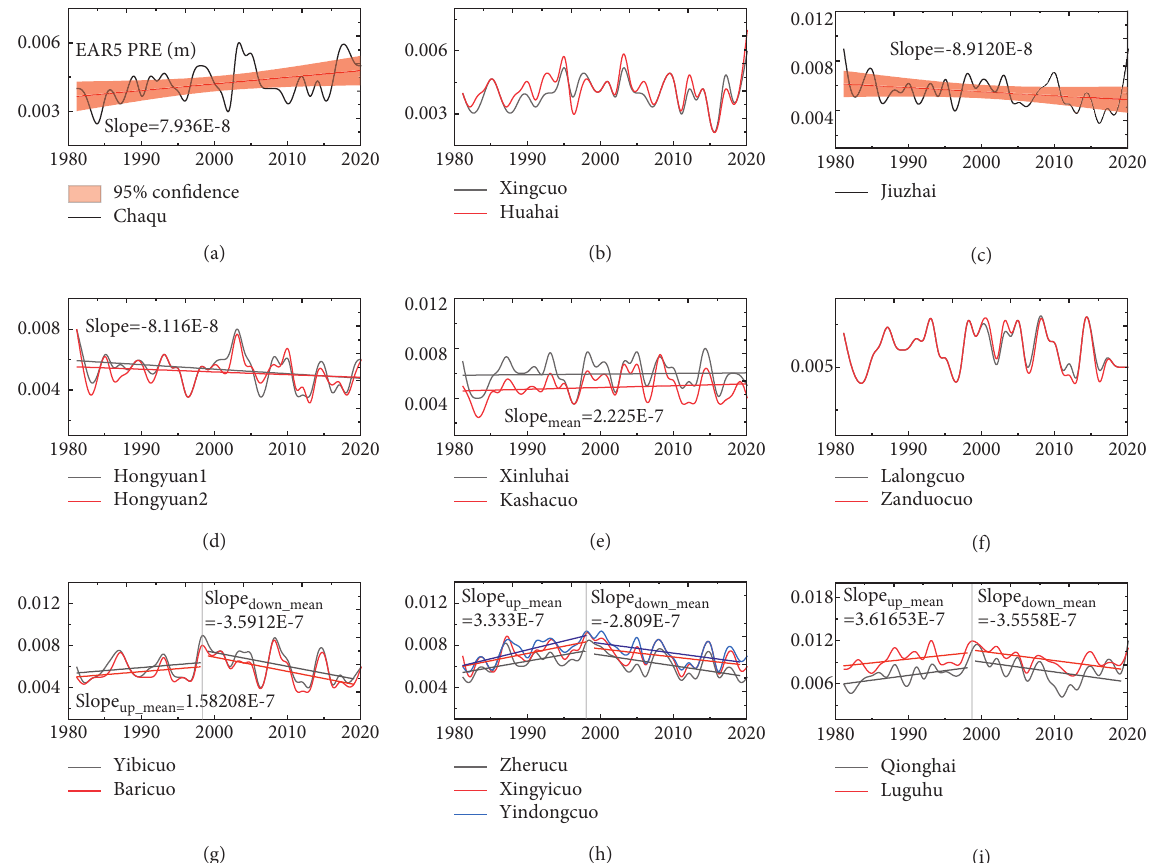
Figure 11: PRE change trend of the lake wetland on a site scale (1980–2020). Latitude of the lake site gradually decreased from subfigure (a) to (i). Elevation of sites (a), (d), (g), (f), and (h) are above 4500m, elevation of sites (b), (c), and (e) are about 3000–3900m, and elevation of site (i) is less than